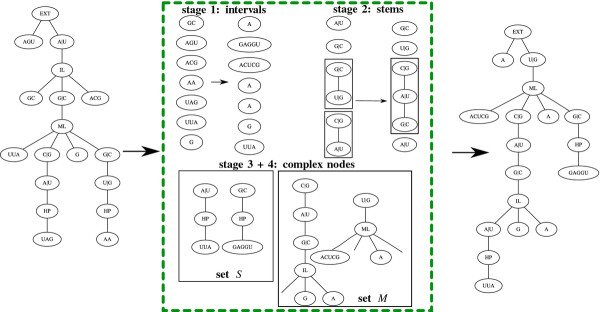
Example of the shuffle process. On the left is the input tree and on the right the output of the process.